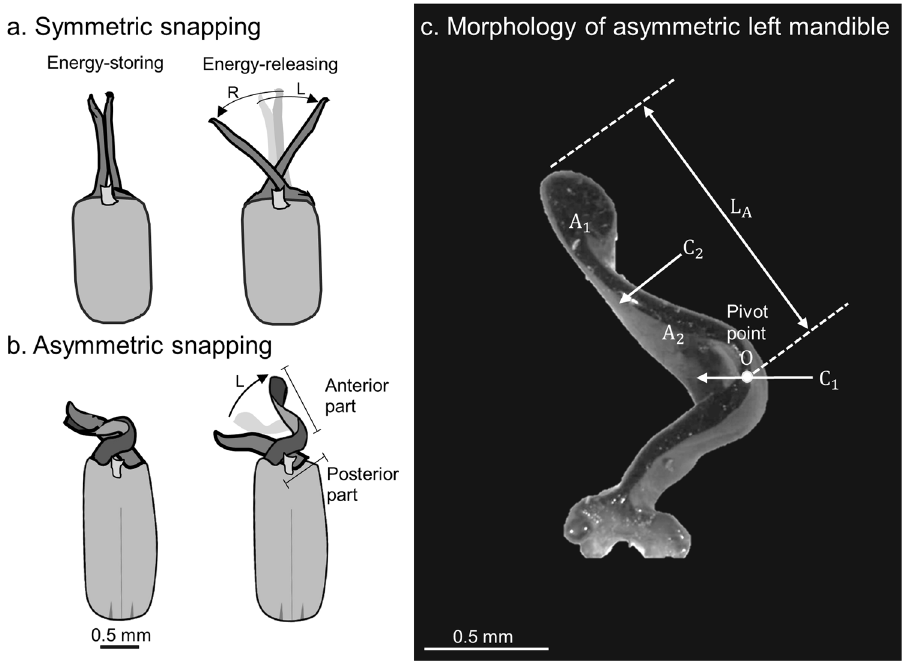
Figure 1. Snapping mandibles of termite soldiers. ( a ) In the symmetric snapping of Termes panamaensi 6,10 , elastic energy is stored in both mandibles, as indicated by the deformation and motion of the left (L) and right (R) mandibles. ( b ) In the asymmetric snapping of Pericapritermes spp. 10 , elastic energy is stored in only the left mandible when its anterior part rotates about the joint or pivot point O. The posterior part remains stationary during snapping. ( c ) Morphology of the twisted left mandible of the Pericapritermes nitobei termite used in this study. The length of the anterior part of the left mandible ( L A ) and the mass of its subsections A 1 and A 2 (i.e., M A1 , M A2 ) are required to estimate its moment of inertia ( I A ). The subsections A 1 and A 2 were prepared by performing two cuts; one cut was made at the pivot point (C 1 ) and the other was made at the centre of the anterior part (C 2